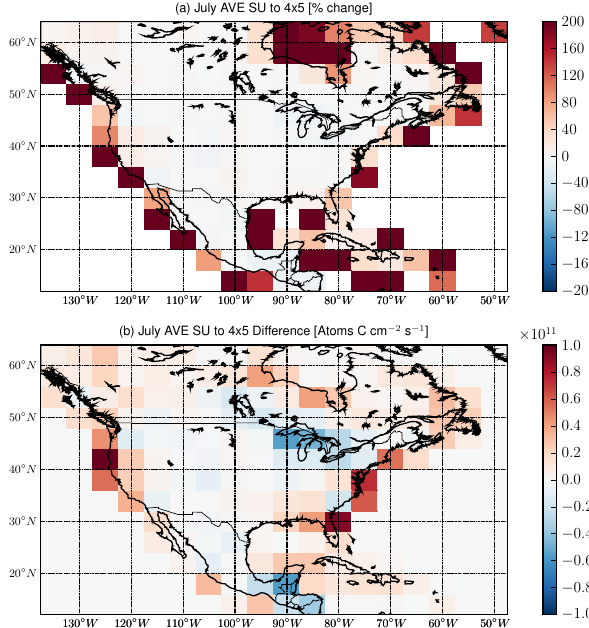
Fig. 8. Isoprene emission comparisons between the scaled up 0.5 ◦ × 0.667 ◦ simulations (SU) and the 4 ◦ × 5 ◦ simulations averaged over July. Panel (a) is the % difference between the SU and 4 ◦ × 5 ◦ isoprene emissions and (b) is the absolute difference (atoms C cm − 2 s − 1 ) .